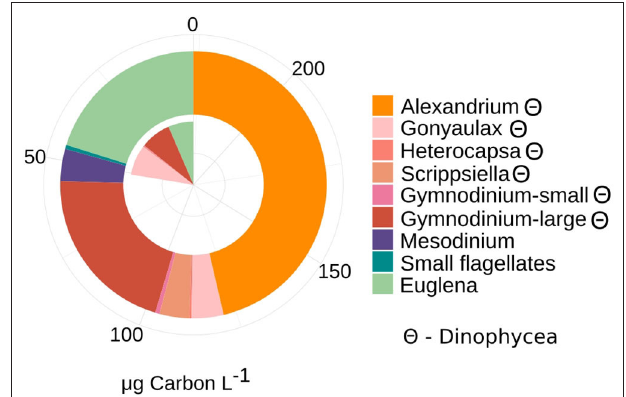
FIGURE 1 | Patterns of phytoplankton and autotrophic ciliate Mesodinium -like community composition ( > 3 µ m) and contribution to total biomass ( µ g Carbon L − 1 ) at T1 and T2. Taxonomic composition was assessed by total microscopy counts and converted into biomass, using C conversion from cell to biomass as factors 0.17 for Cyanophycea ( filamentous ) and 0.15 for small phototrophic flagellates (Olenina et al., 2006). Carbon unit (pg C cell − 1 ) were calculated based on cell volume for the genera Alexandrium (7,723 pg C cell − 1 ), Gonyaulax (1,300 pg C cell − 1 ), Heterocapsa (160 pg C cell − 1 ), Scrippsiella (806 pg C cell − 1 ), Gymnodinium (large: 1,730, small: 51 pg C cell − 1 ), Euglena (120 pg C cell − 1 ), Mesodinium (2,630 pg C cell − 1 )